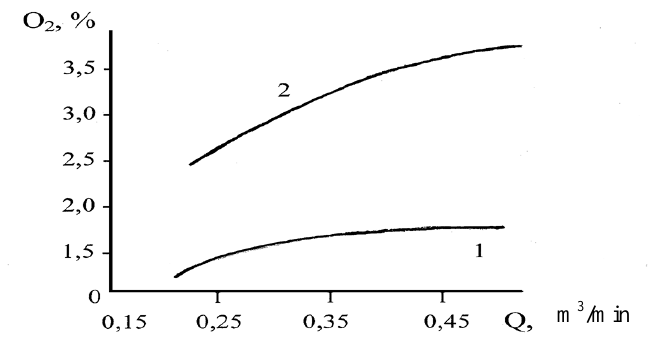
Fig. 3. Influence of the flow rate of spraying air on the oxygen content in coatings obtained by (1) mode 2 and